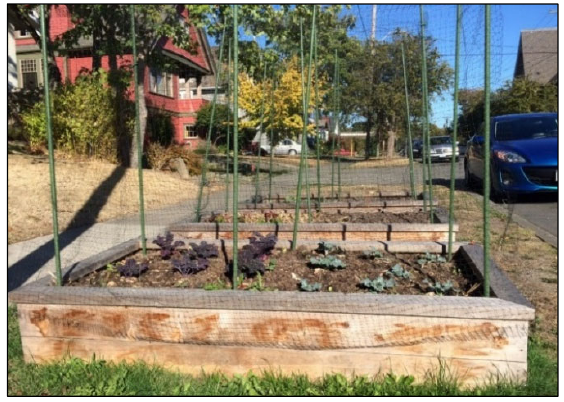
Figure 6. Boulevard Garden beside a Retaining Wall Planted with Winter Squash and Tomato